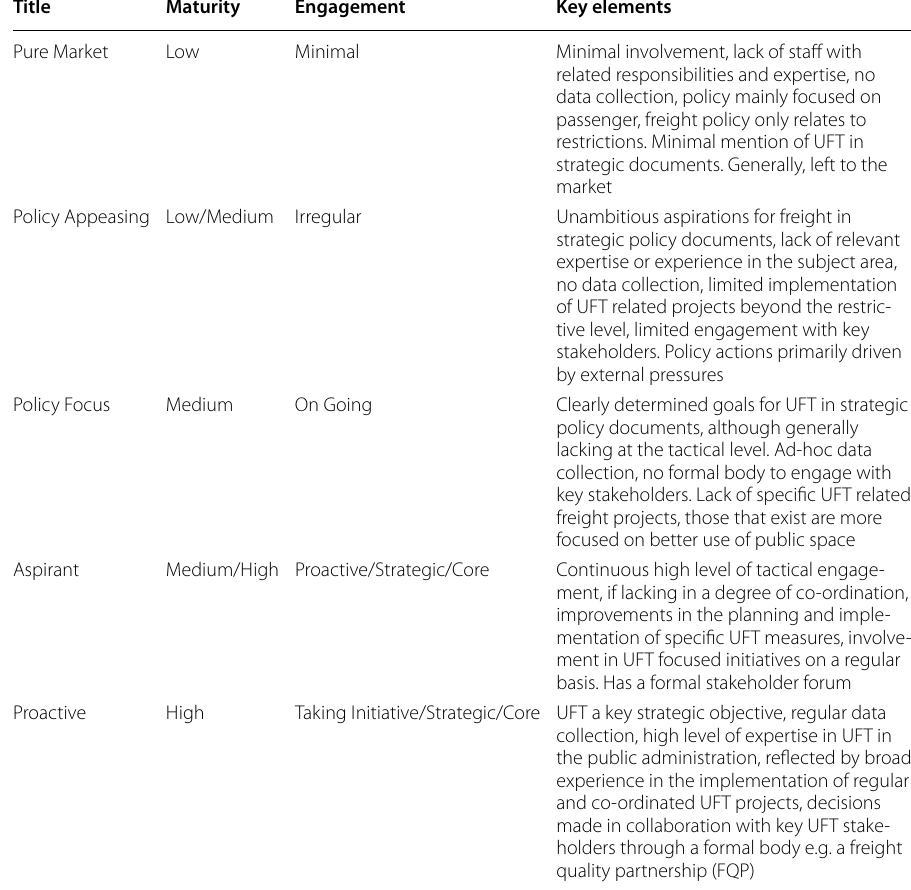
Table 1 Levels of urban freight transport (UFT) policy maturity Title Maturity Key